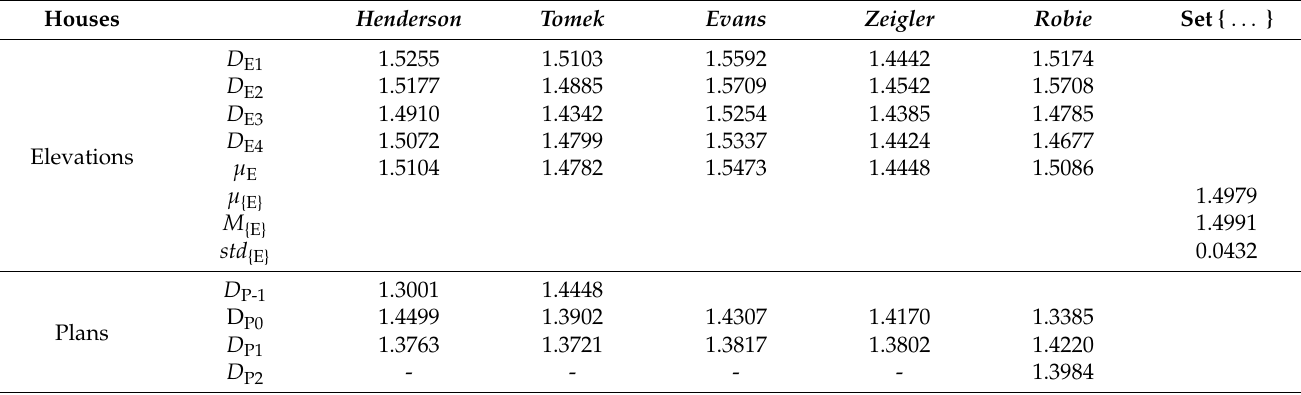
Table A1. Prairie set